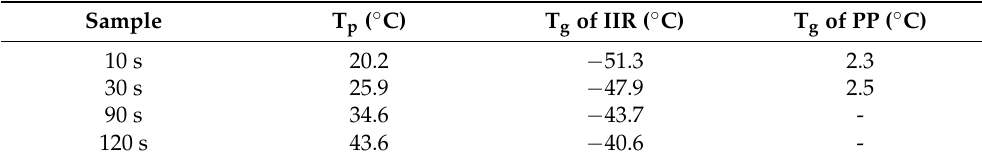
Table 1. T p and T g of IIR/PP-TPV with different DV